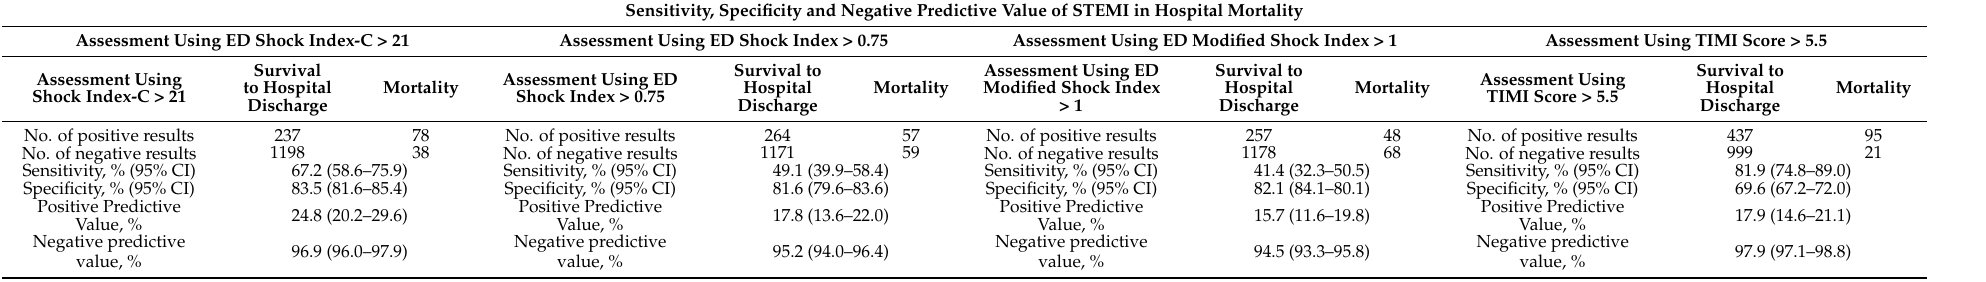
Table 5. Sensitivity, specificity, positive predictive value, and negative predictive value of the SI, MSI, SIC and TIMI risk scores for in-hospital mortality of STEMI patients; ED, emergency department; TIMI, thrombolysis in myocardial infarction; CI, confidence interval. Sensitivity, Specificity and Negative Predictive Value of STEMI in Hospital